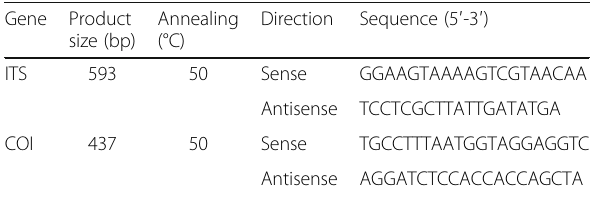
Table 1 PCR conditions and primer sequence of ITS and COI genes of B.